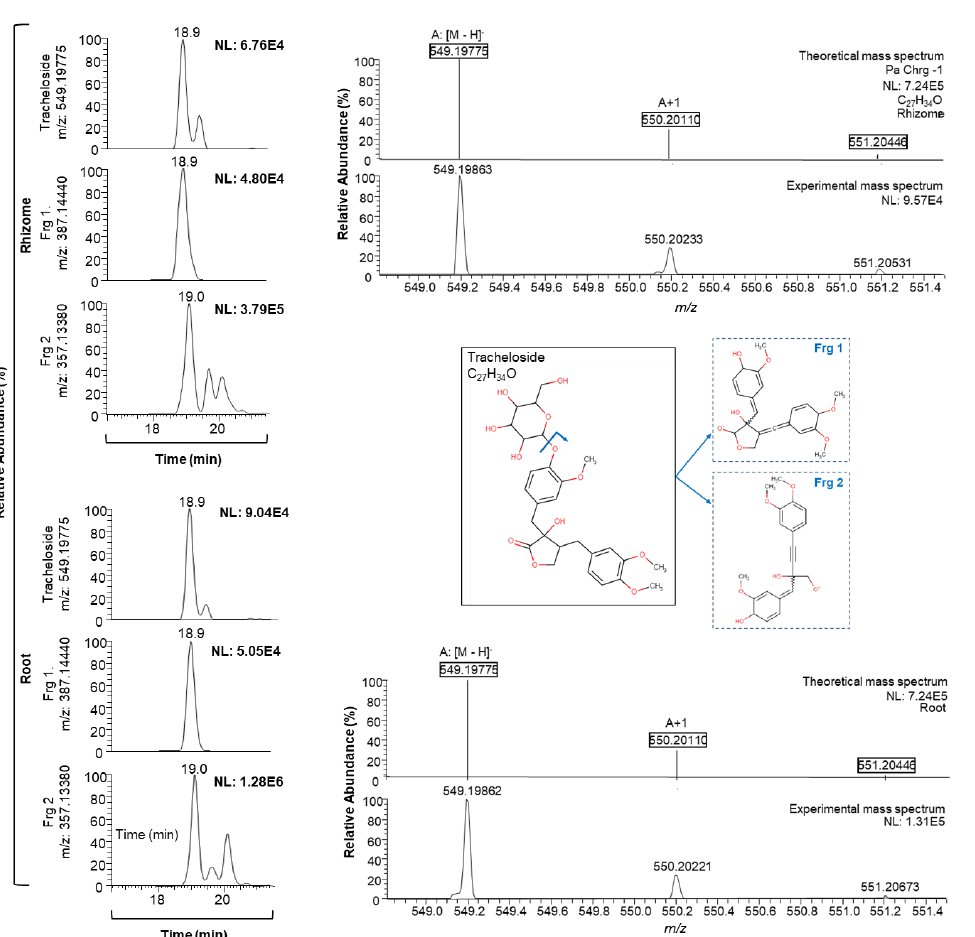
Figure 3. Extracted ion chromatogram of the first time detected and non-target bioactive compound tracheloside ( m/z : 549.19775), in P. oceanica rhizome and root (sampling point CG4) and the corresponding mass spectrum. NL: intensity, Frg.: confirmation